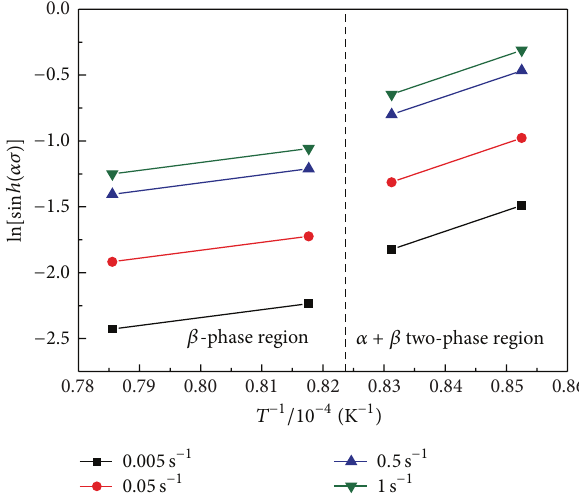
Figure 4: The relationships between ln ̇𝜀 and 𝜎 .